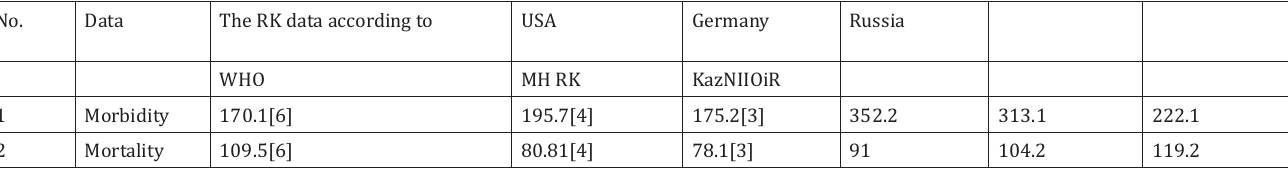
Comparative data on morbidity and mortality from cancer in the Republic of Kazakhstan with economic developed countries of the world in 2018 (per 100,000